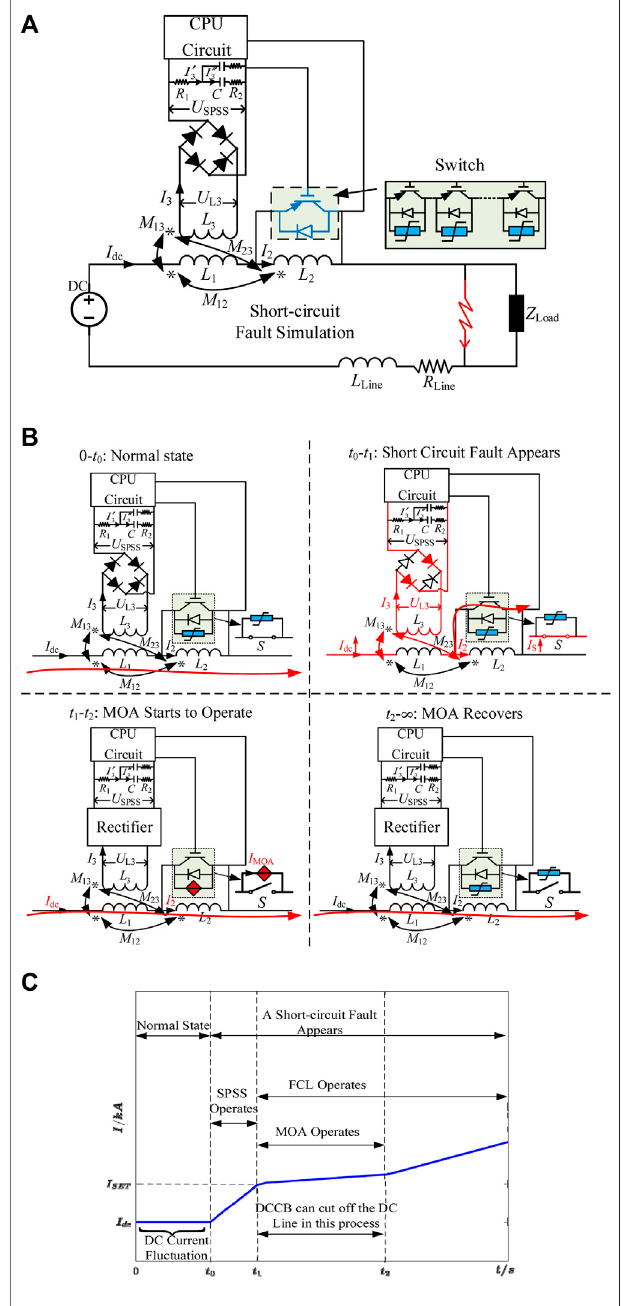
FIGURE 5 | SCCSSFCL with SPSS installed on a DC system. (A) Con fi guration of the SCCSSFCL with SPSS. (B) Different states of the SCCSSFCL with SPSS. (C) Current waveform of the DC